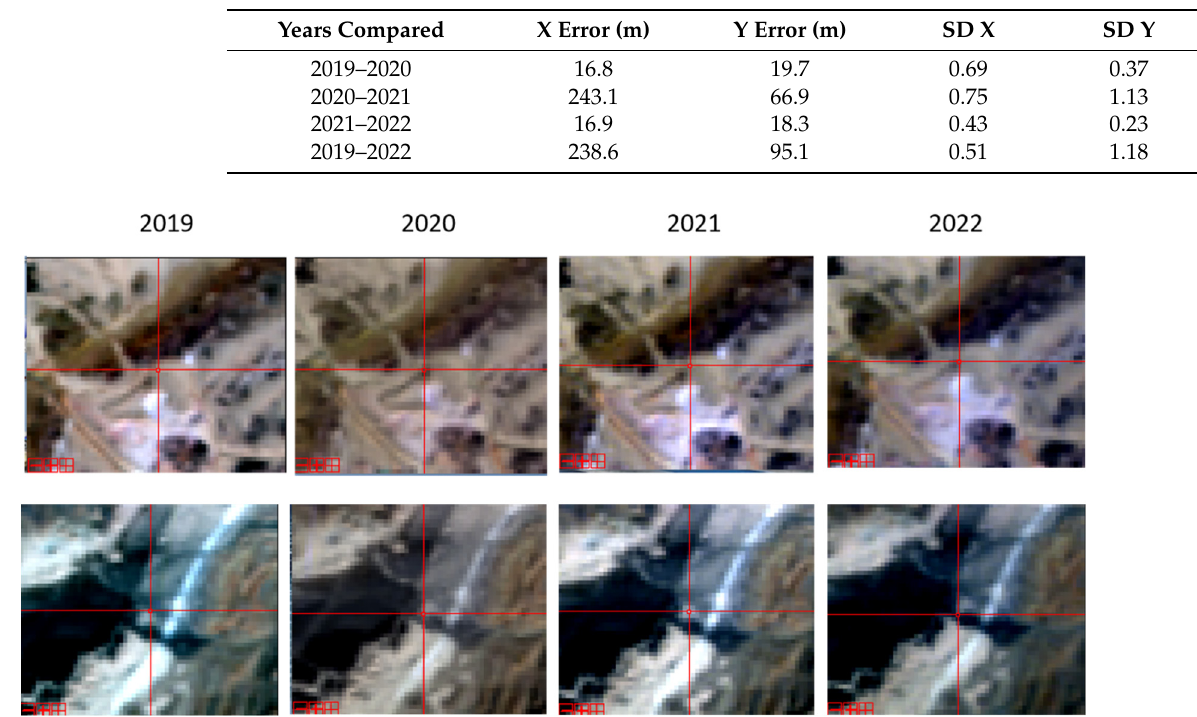
Table 5. Shifts in longitudinal (X) and latitudinal (Y) location for 200 GCPs at MR, between years 2019 and 2022. Average error and standard deviation were calculated.